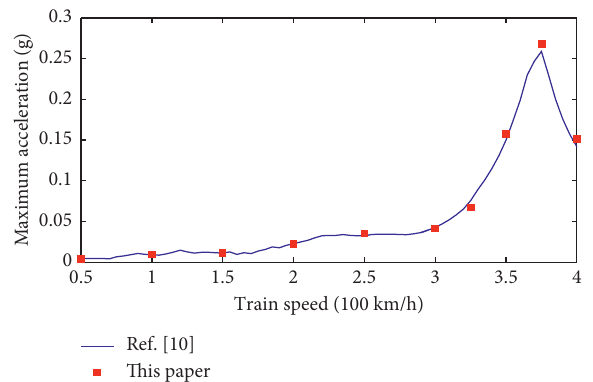
Figure 2: Comparisons of bridge acceleration versus train speed obtained from this model and from the study by Yang and Yau [10].